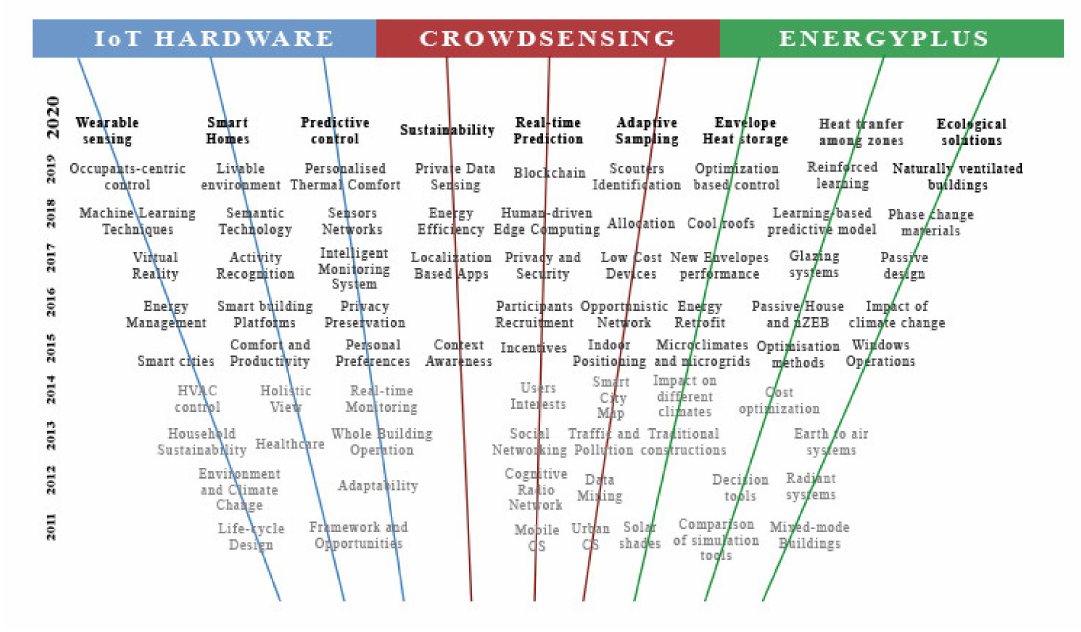
Figure 5. Tree of main topics based on thermal comfort in the last